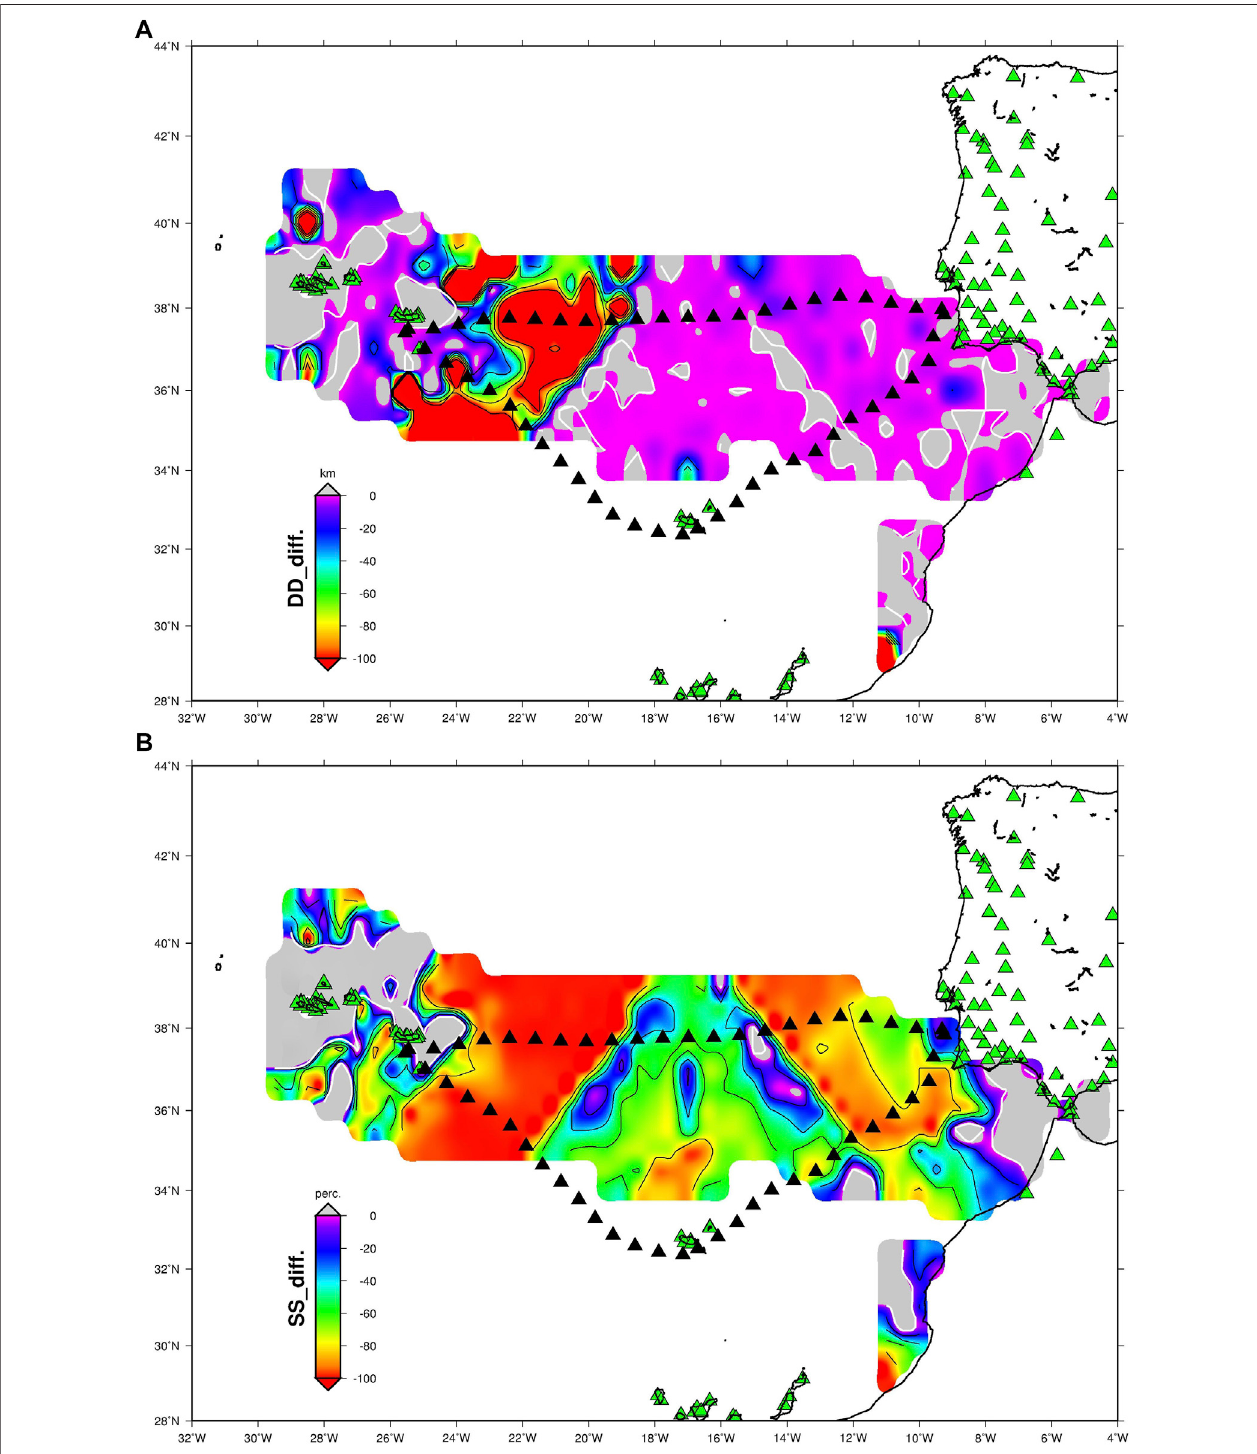
FIGURE8| MeasureoftheaddedvalueoftheSMARTcablestotheearthquakefastparameterdeterminationusingMonte-Carlosimulations.Greentrianglesshow the land seismic stations while the cabled stations are shown as blue triangles. (A) Difference between “ land plus cabled ” and land only networks for the DD quality parameter. (B) Difference between “ land plus cabled ” and land only networks for the SS quality parameter, in %. On both images red areas show the domains were the difference is less than the maximum value, light grey areas show the domains were no improvement was observed.